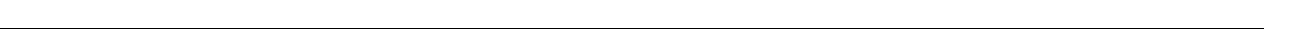
Figure 5 | QKI influences mRNA transcript abundance during differentiation of THP-1 monocyte-like cells to THP-1 macrophage-like cells. ( a ) mRNA expression of the QKI isoforms as compared with glyceraldehyde 3-phosphate dehydrogenase (GAPDH) in THP-1 ‘monocytes’ and 8 days differentiated THP-1 ‘macrophages’ (biological n ¼ 3). Data expressed as mean ± s.e.m.; Student’s t -test; * P o 0.05 and ** P o 0.01. ( b ) Western blot analysis of whole-cell lysates of THP-1 ‘monocytes’ and THP-1 ‘macrophages’. ( c ) Western blot quantification of QKI protein isoforms, normalized to b -actin in THP-1 ‘monocytes’ and THP-1 ‘macrophages’ ( n ¼ 3). Data expressed as mean ± s.e.m.; Student’s t -test; ** P o 0.01. ( d ) Hierarchical clustering (Euclidean algorithm) of key monocyte differentiation genes depicting changes in microarray-derived mRNA abundance THP-1 ‘monocytes’ (left two lanes) and THP-1 ‘macrophages’ (right two lanes), where dark blue ¼ low expression, whereas light blue ¼ high expression (* and/or # beside gene name is indicative of a significant Z 1.5- fold change in expression in monocytes or macrophages, respectively). ( e ) Venn diagrams depicting the number of microarray-derived differentially expressed genes (minimally ± 1.5-fold; sh-QKI/sh-Cont expression, q -value r 0.05) for unstimulated THP-1 ‘monocytes’ (left Venn diagram) and THP-1 ‘macrophages’ (right Venn diagram). ( f ) The most significantly differentially expressed genes harbouring a QRE are shown. ( g ) Genome-wide scatterplot of mRNA abundance in THP-1 ‘monocytes’ (left scatterplot) and THP-1 ‘macrophages’ (right scatterplot); y axis: Log 10 probe intensity versus the x axis: log2FC: sh-QKI average probe intensity/sh-Cont average probe intensity. Blue dots indicate QRE-containing transcripts that are minimally ± 1.5 fold differentially expressed ( q r 0.05). Grey dots do not fulfill these criteria. ( h ) CDF ( y axis) for QKI target (QRE containing: blue line) and non-target (non- QRE containing: cyan line) mRNAs ( x axis: log 2 FC) in THP-1 ‘monocytes’ (left plot) and THP-1 ‘macrophages’ (right plot). Left shift indicates lower expression of QKI target genes in the sh-QKI samples, whereas a right shift is indicative of higher expression of QKI targets in the sh-QKI samples. Distributions were compared using a Wilcoxon rank-sum